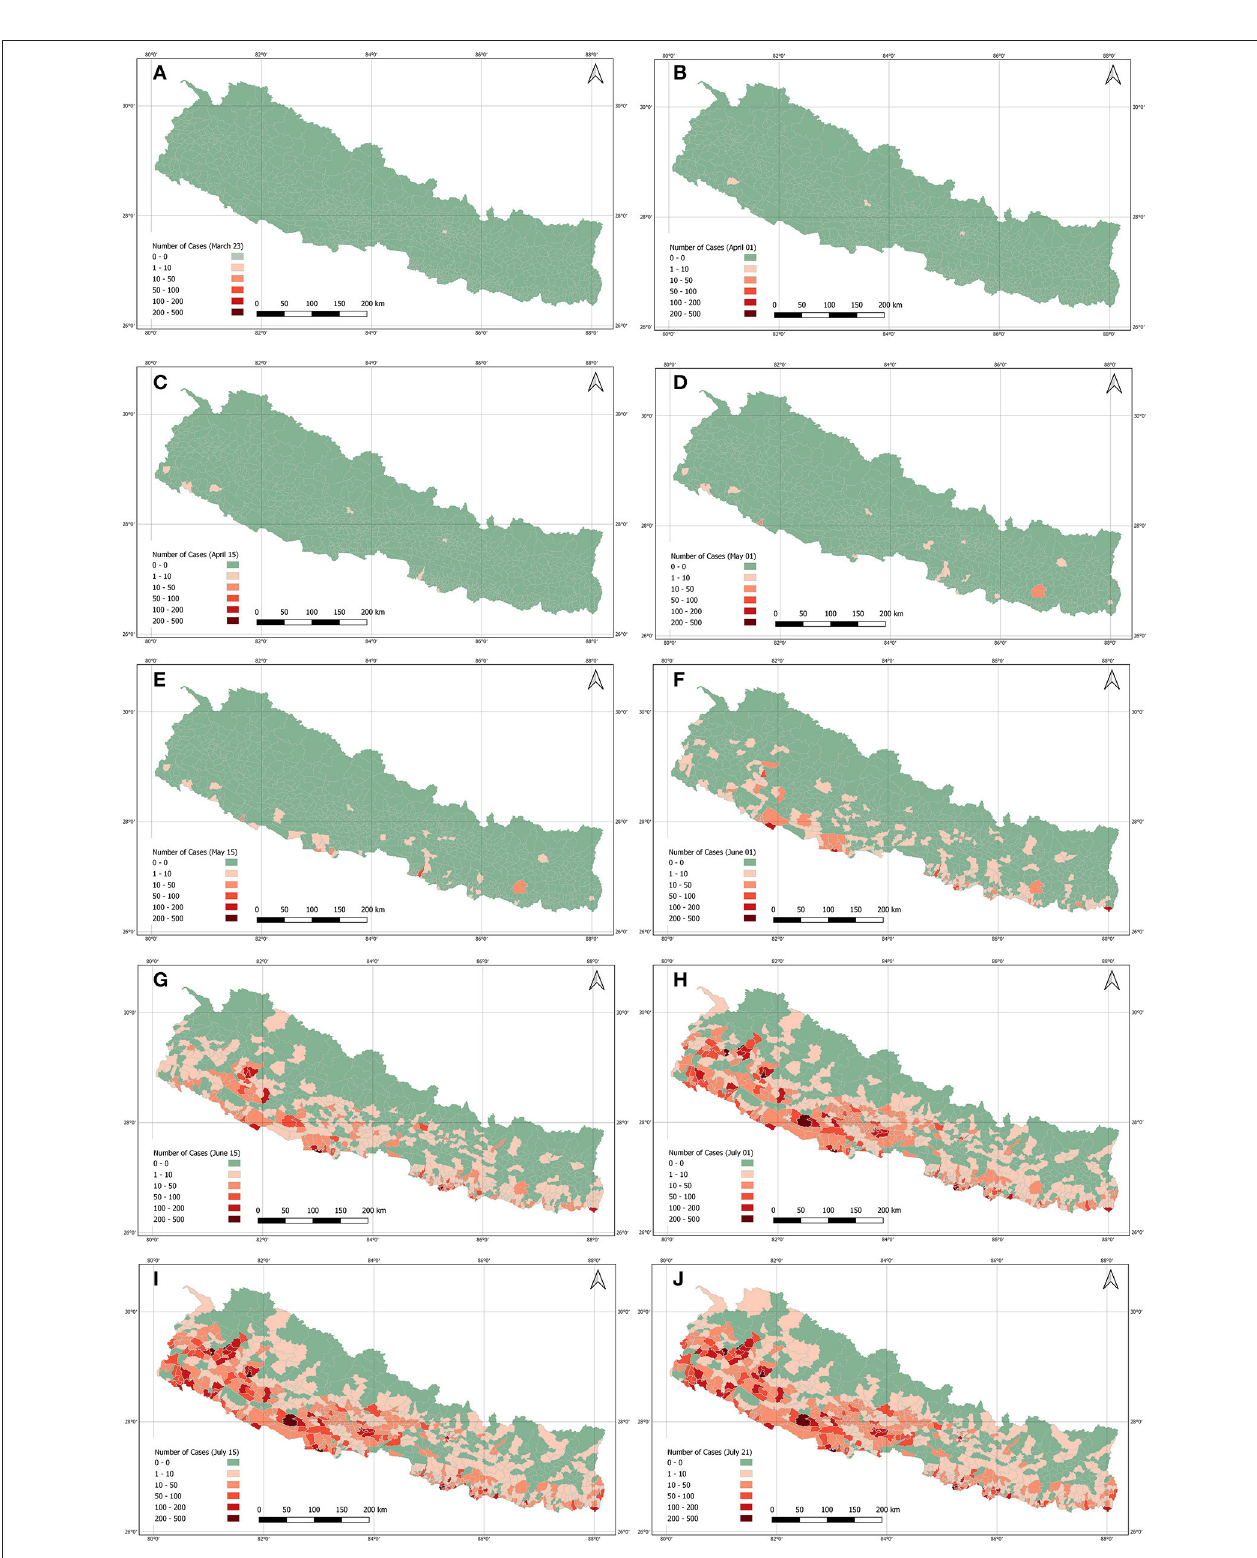
FIGURE 5 | Total positive COVID-19 cases across the country by date during lockdown period. (A) : March 23. (B) : April 01. (C) : April 15. (D) : May 01. (E) : May 15. (F) : June 1. (G) : June 15. (H) : July 1. (I) : July 15. (J) : July 21.